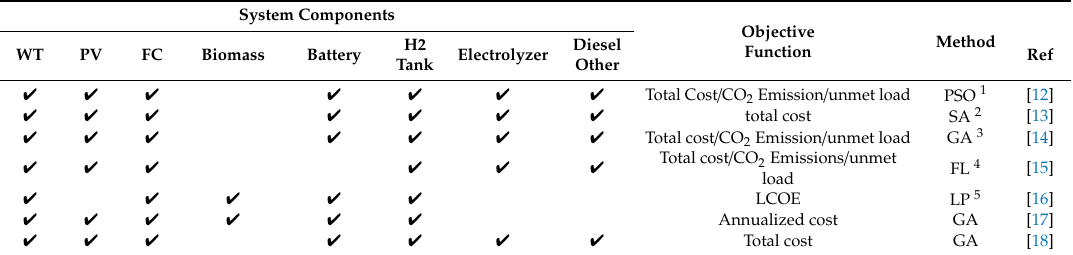
Table 1. Summary review on hydrogen-based hybrid renewable energy system (HRES) configuration and modeling